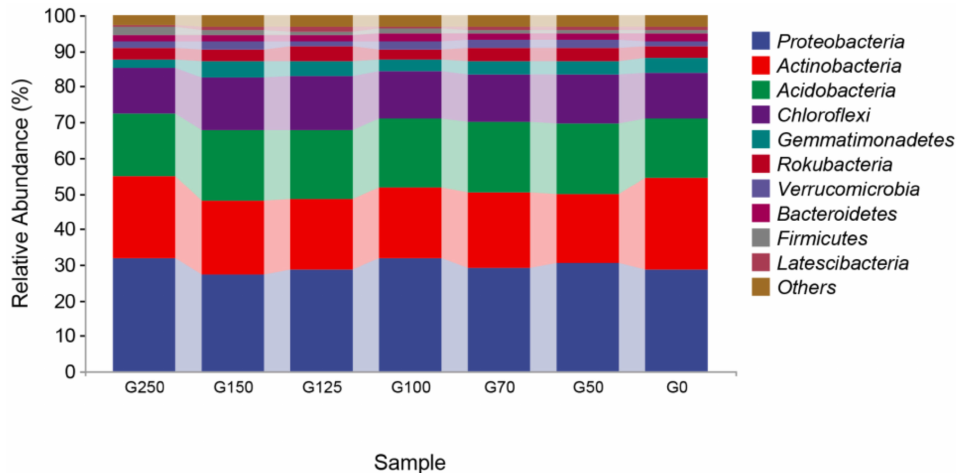
Figure 2. Phylum distribution of soil bacteria in different-sized forest gaps.